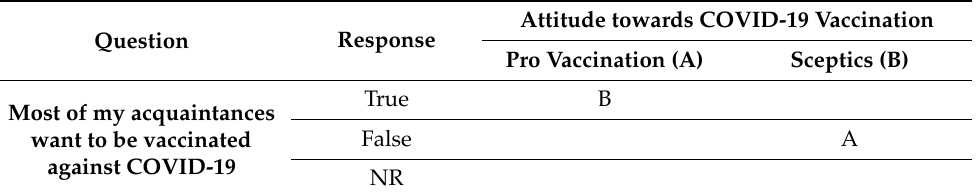
Table 6. Provaccination vs. skeptical population on ‘Most of my acquaintances want to be vaccinated against COVID-19’.